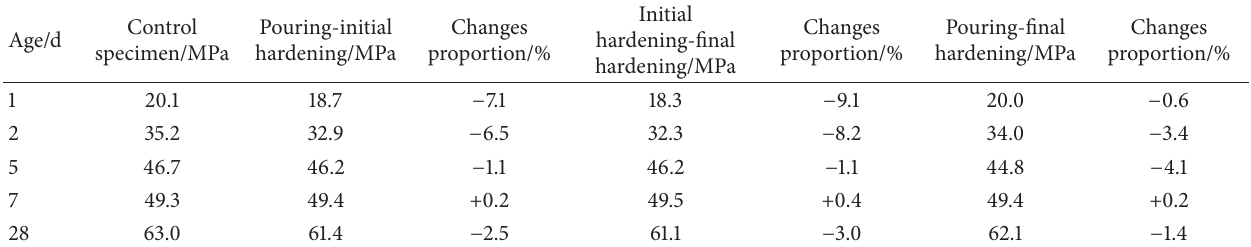
Table 2: Compressive strength and rate of change of HPC specimens with vibration parameters of 2 Hz and 3 mm. Age/d